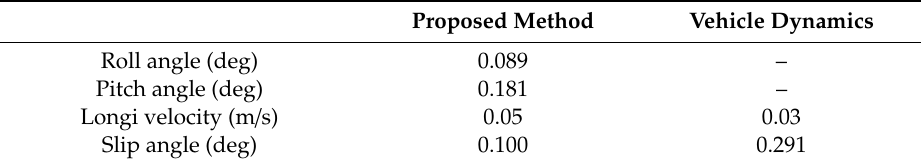
Table 4. RMS of estimation errors in slalom